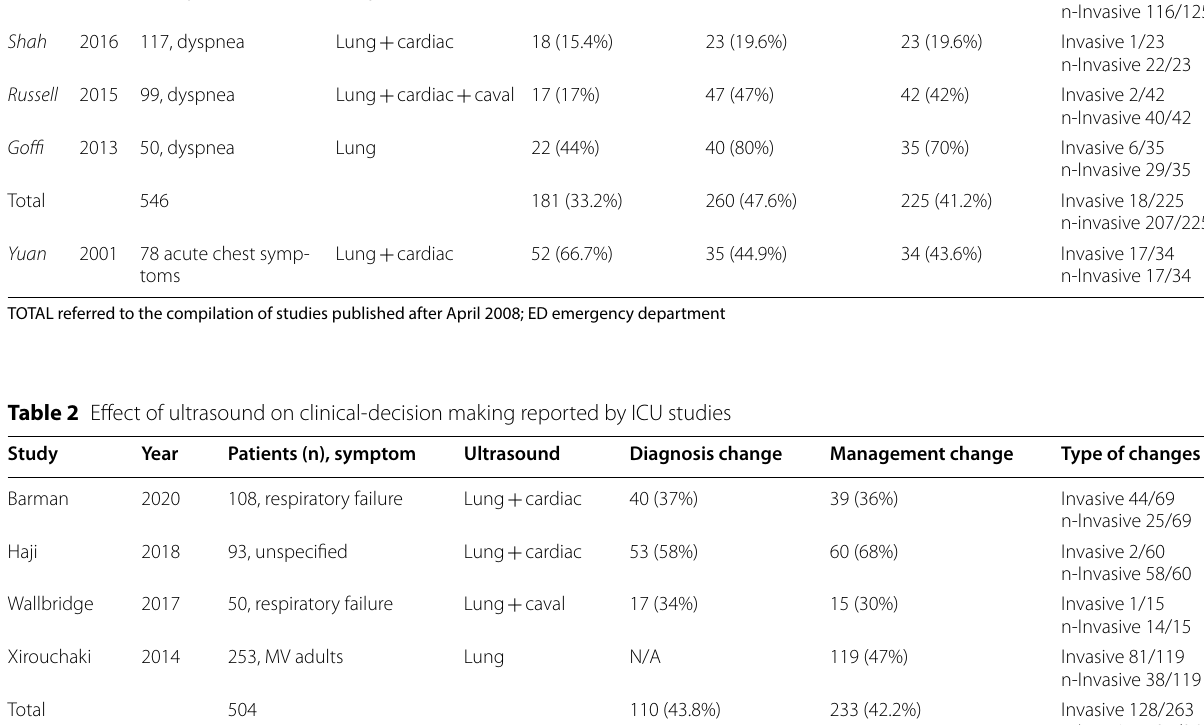
Table 1 Effect of ultrasound on clinical-decision making reported by ED studies Study Year Patients (n), symptom